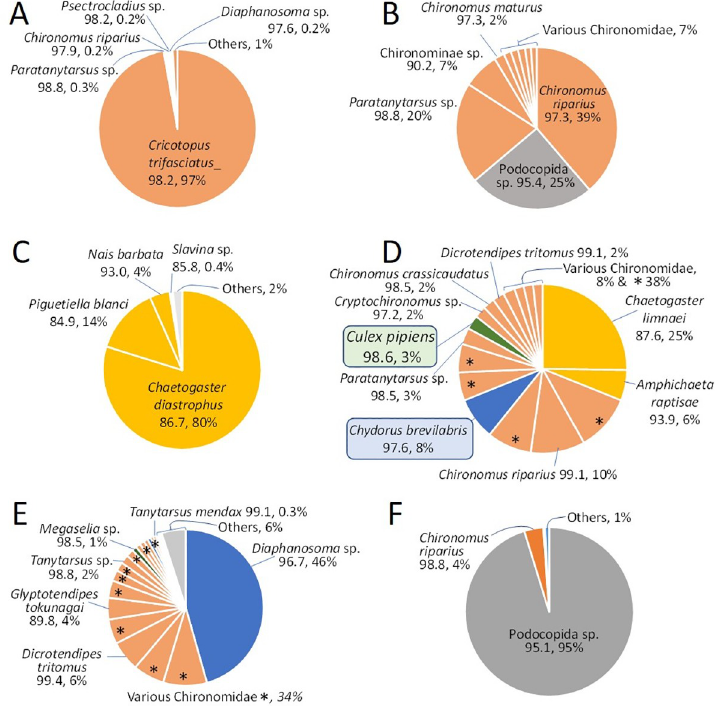
Fig 6. Abundance of OTUs within representative water mites. (A, B) L . davidcooki ; (C-E) L . quinquemaculosa ; (F) Arrenurus . Pie sections are proportional to the percent abundance in that mite and labeled with the name of the “best hit” reference sequence, percent identity of the OTU with the reference sequence, and it’s percent abundance. Pie sections with � are OTUs with best matches to a variety of Chironomidae or identified only to that level as the best hit.